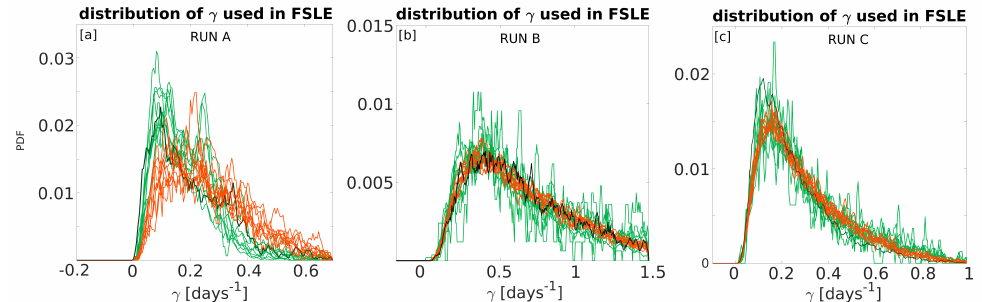
Figure 9. ( a ) Probability density function of the values of γ used in the computation of the FSLE λ at the reference separation threshold r i = 0.35 for model run A. Each line represents a different initial separation. Green and red lines represent initial separations that are smaller and larger than the reference separation r i , respectively. ( b ) Same as ( a ) for model run B. ( c ) Same as ( b ) for model run